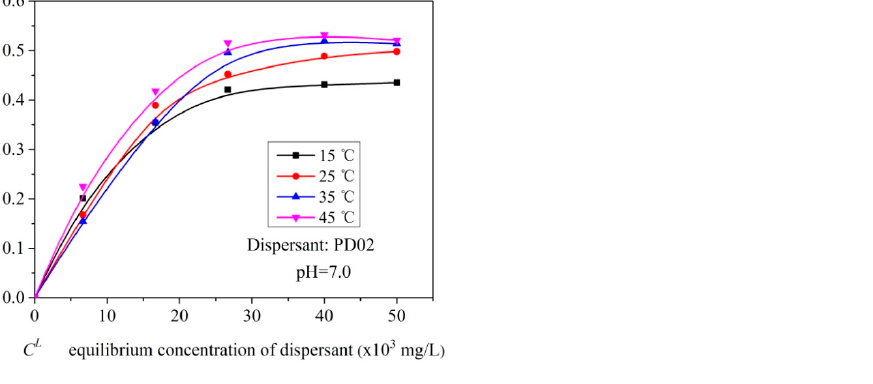
Figure 9. The adsorption isotherms for dispersants PD02 adsorbed on the surface of pigment particles at different temperatures. Table 4. Parameters simulated by the Langmuir equation and Freundich equation.